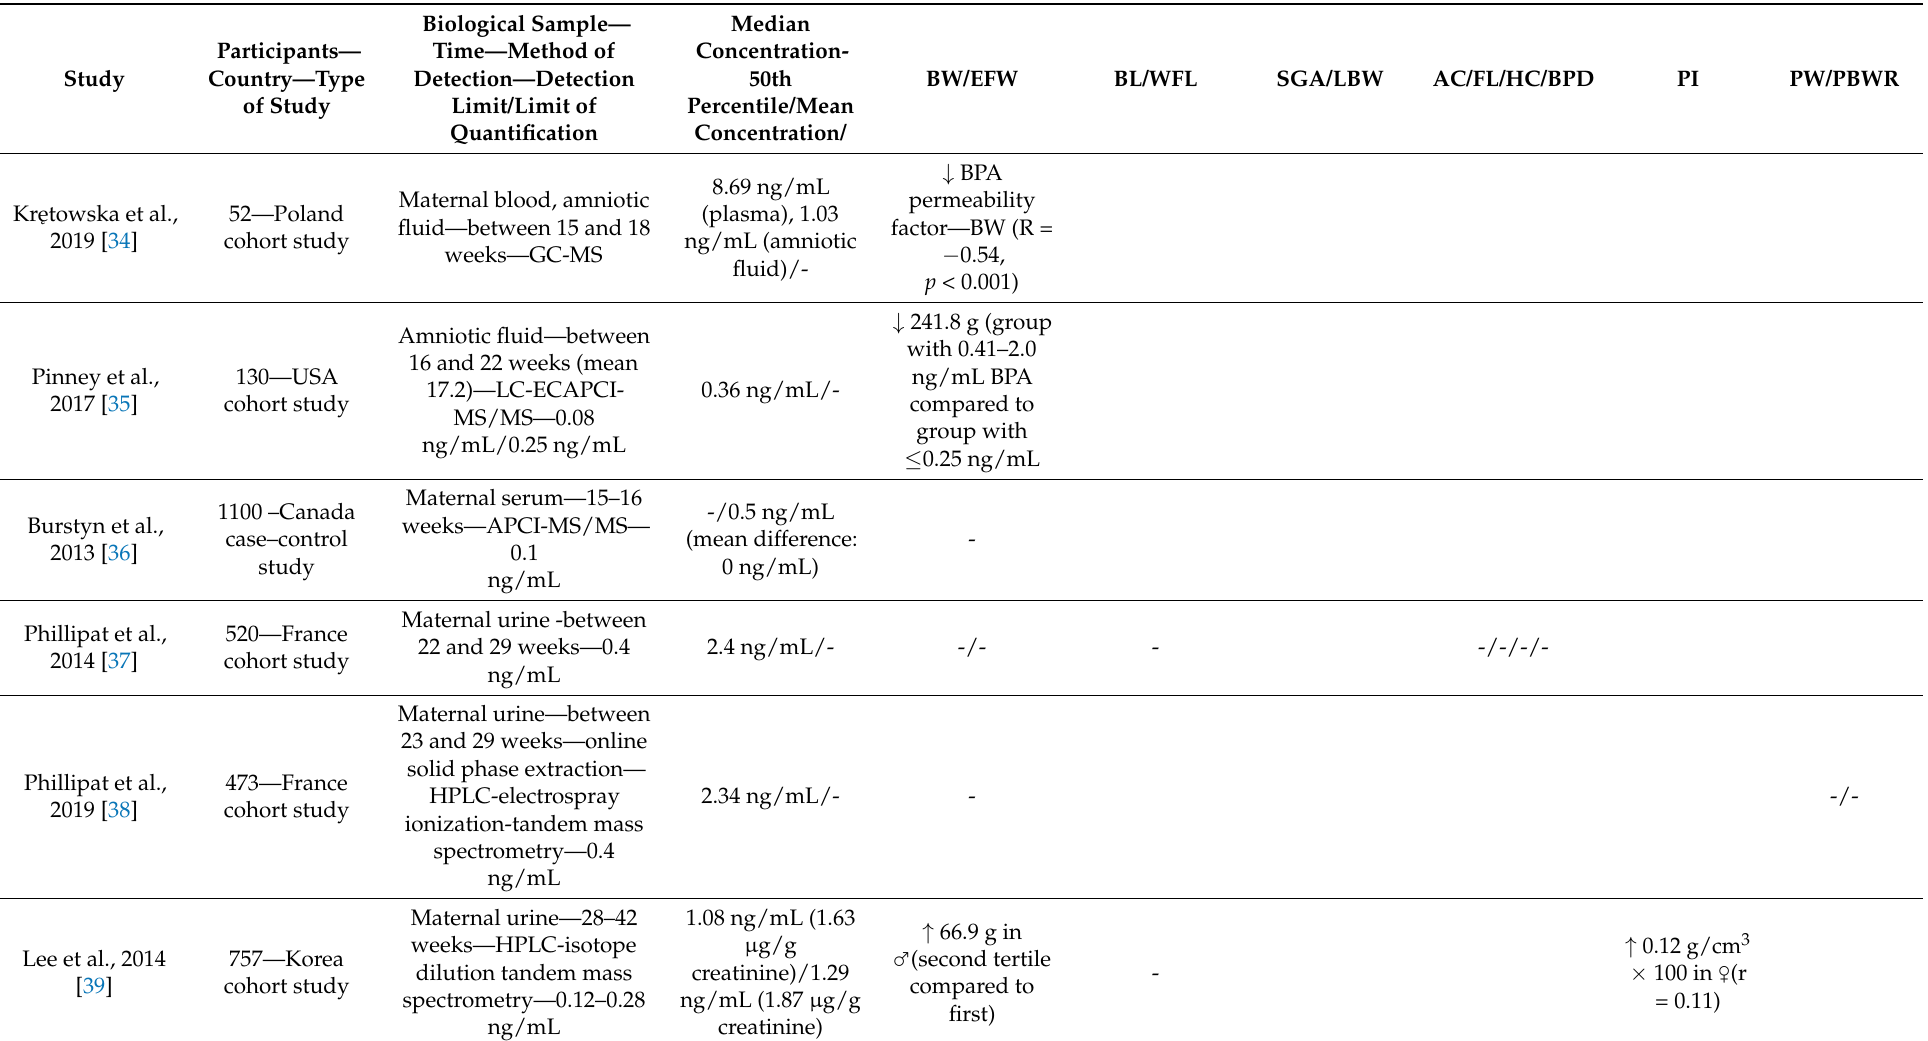
Table 3. Studies on the association of BPA with fetal